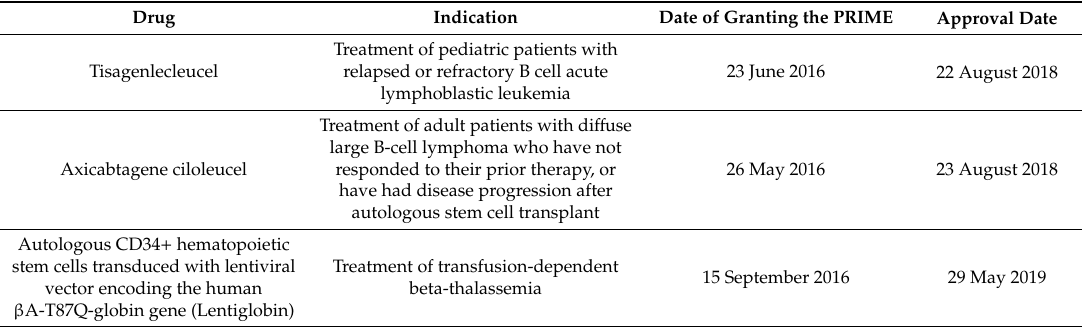
Table 9. Medical products that were granted the priority medicine (PRIME) designation that were granted marketing authorization in the EU as of 7 June 2019. Indication Date of Granting the PRIME